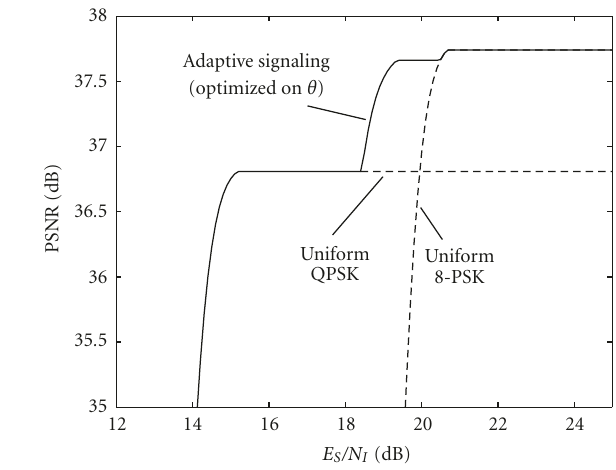
Figure 7: PSNR as a function of E S /N I in dB for single-layer schemes employing uniform MPSK: QPSK and 8-PSK, without channel coding for AWGN channel. Fixed symbol transmission rate r S = 128 Ksps.